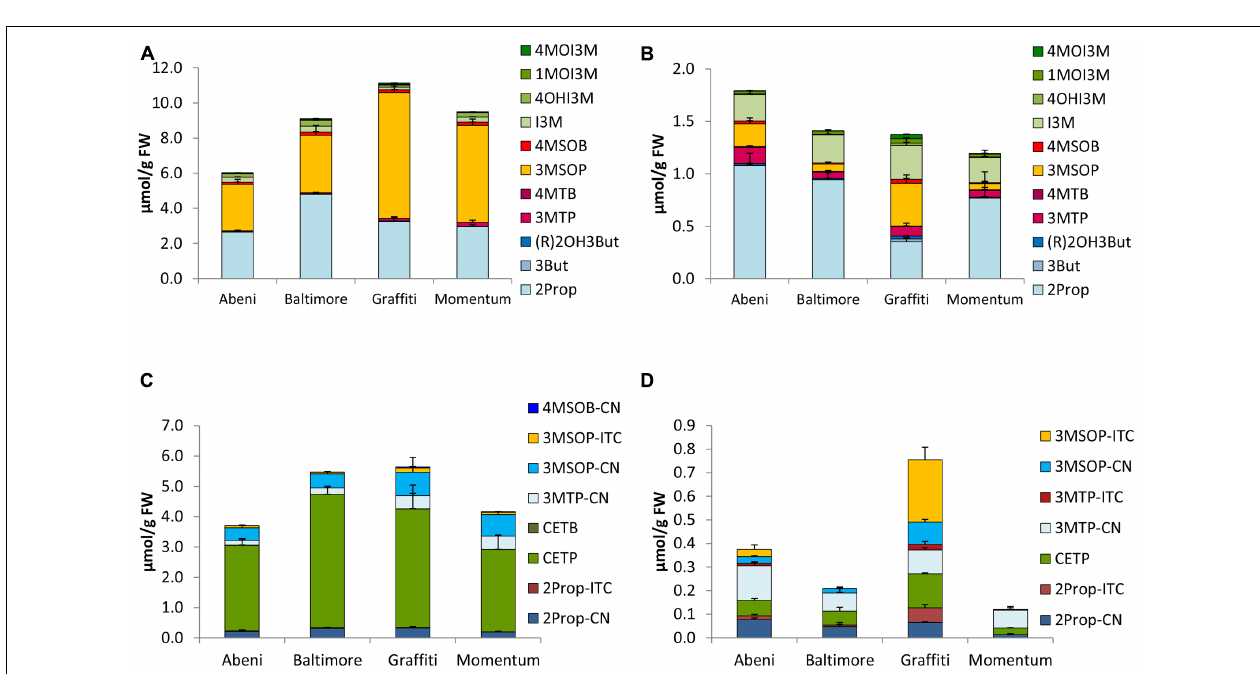
3MSOP-ITC, 4MSOB-ITC, and 2PE-ITC], the ITC derivates oxazolidine-2-thione (OZT), and 1-methoxyindol-3-carbinol (1MOI3C), and three EPTs [CETP, 1-cyano-3,4-epithiobutane